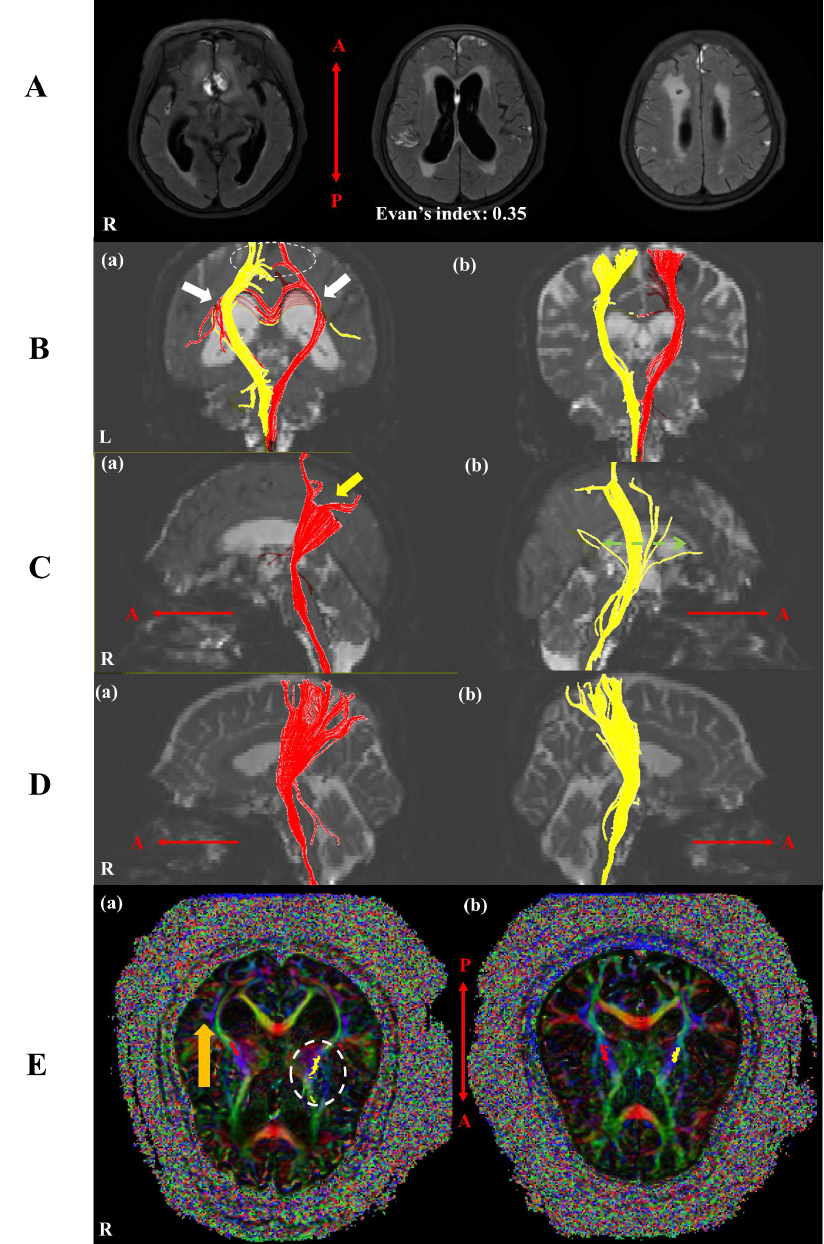
Figure 2. ( A ) Brain magnetic resonance images obtained at week 4 after onset showing clearance of subarachnoid blood with persisting bilateral ventriculomegaly (Evan’s index: 0.35) with interstitial edema and encephalomalacia in both frontal lobes (severe enlargement of the left ventricle). ( B ) (a) Changes in both CSTs were observed around both lateral ventricles due to bilateral ventriculomegaly versus the control subjects (70 years old female, white arrow) and a discontinuity of both tracts to the bilateral cortex was apparent (white dash circle) (b) control. ( C ) (a) The right CST did not extend to the right cortex (yellow arrow) and (b) the left CST spread out (green dash arrow). ( D ) CSTs of a control subject. ( E ) (a) The right CST (red) was posteriorly shifted at the corona radiata (orange arrow) and the left CST (yellow) was spread out compared with control subjects (white dashed circle). (b) Left and right CSTs of a control subject. Note: R, right; L, left; A, anterior; P,